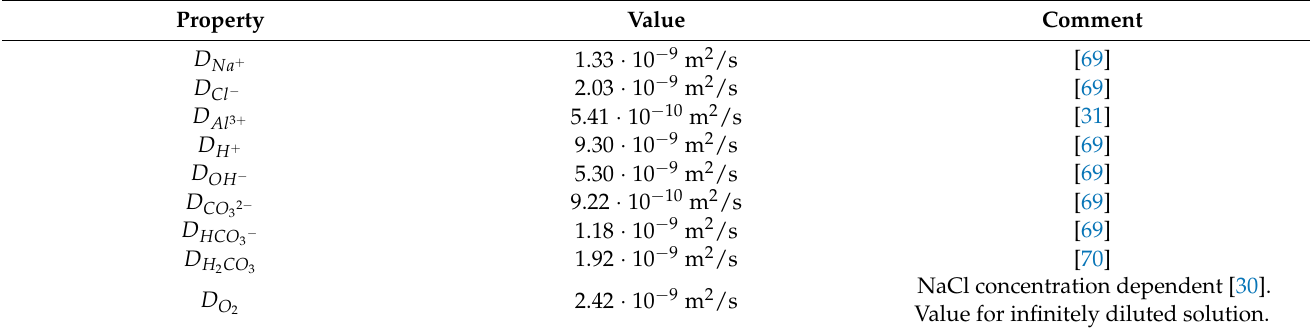
Table 2. Mass transport properties at 25 ◦ C. All aluminum species not listed set equal to D Al 3 +